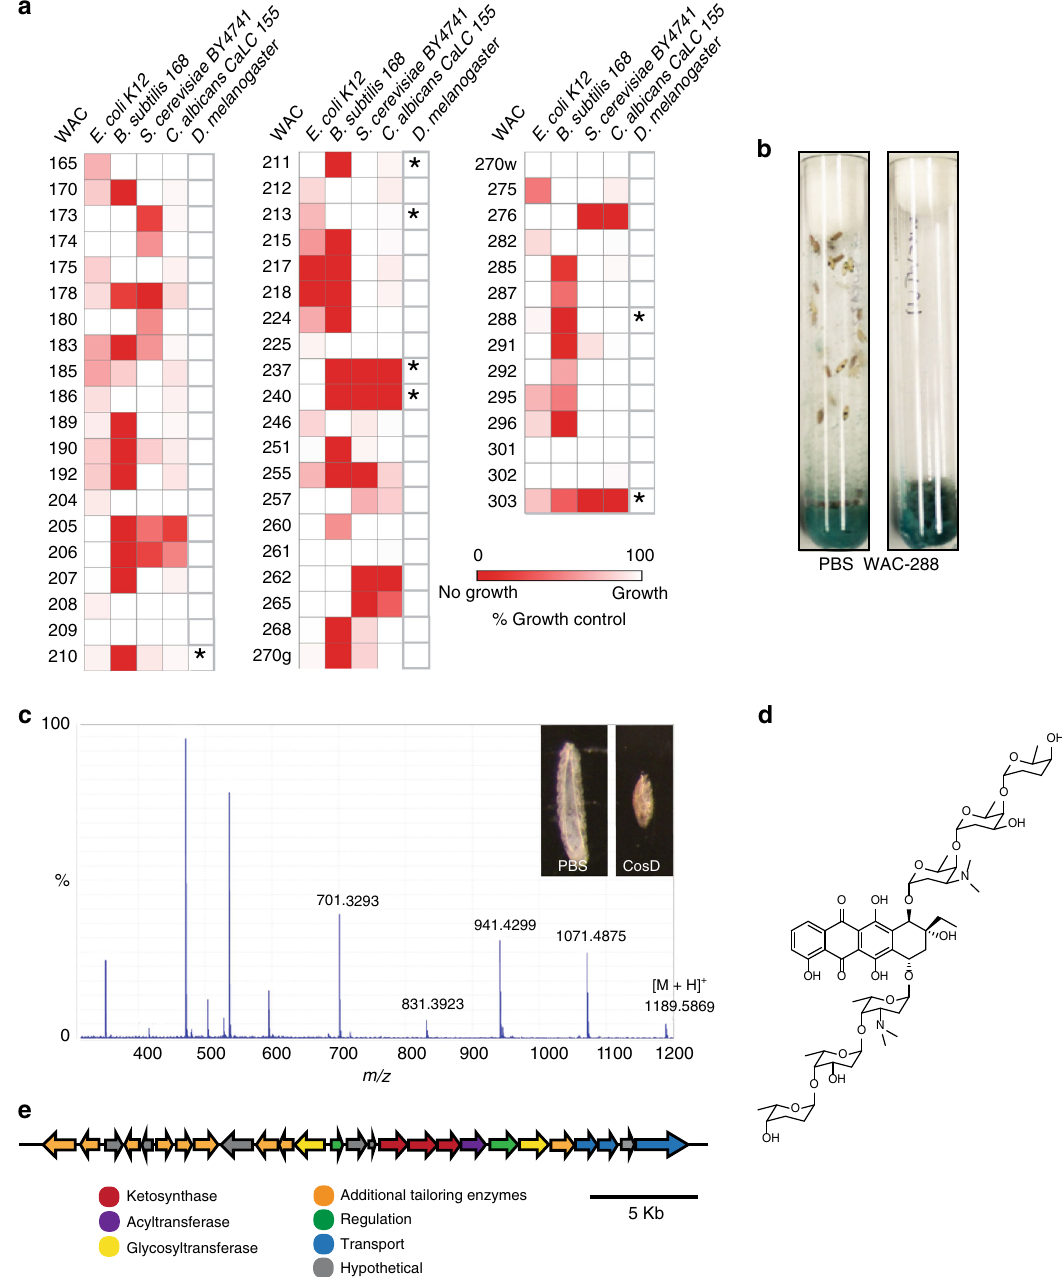
Fig. 1 Identifying insecticidal bioactivity in actinomycete extracts. a A set of 56 crude extracts derived from the Wright Actinomycete Collection (WAC) were generated and tested for growth inhibition against model prokaryote ( E. coli, B. subtilis ), yeast ( S. cerevisiae , C. albicans ) and insect ( D. melanogaster ) model organisms. Visualized is each extract ’ s inhibitory activity against corresponding model organisms where values of microbial growth are relative to the DMSO control. Asterisks (*) indicate extracts that had larvicidal activity whereby no larvae developed into adult fl ies. b Shown is the activity of an extract from WAC-288 which inhibited the development of D. melanogaster larvae into adult fl ies. c The molecule with larvicidal activity was puri fi ed from WAC-288 and its identity was con fi rmed via tandem MS/MS fragmentation analysis. The parent ion and the masses of corresponding fragments were identi fi ed (Supplementary Fig. 2). d Structure of the antibiotic cosmomycin D. e Biosynthetic gene cluster identi fi ed from the sequenced genome of WAC- 288 corresponding to cosmomycin D